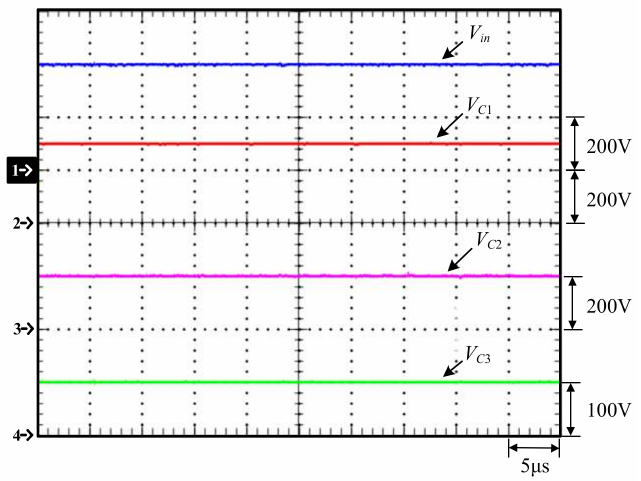
Figure 17. Measured waveforms relevant to rated load: (1) V in ; (2) V C 1 ; (3) V C 2 ; (4) V C 3 .